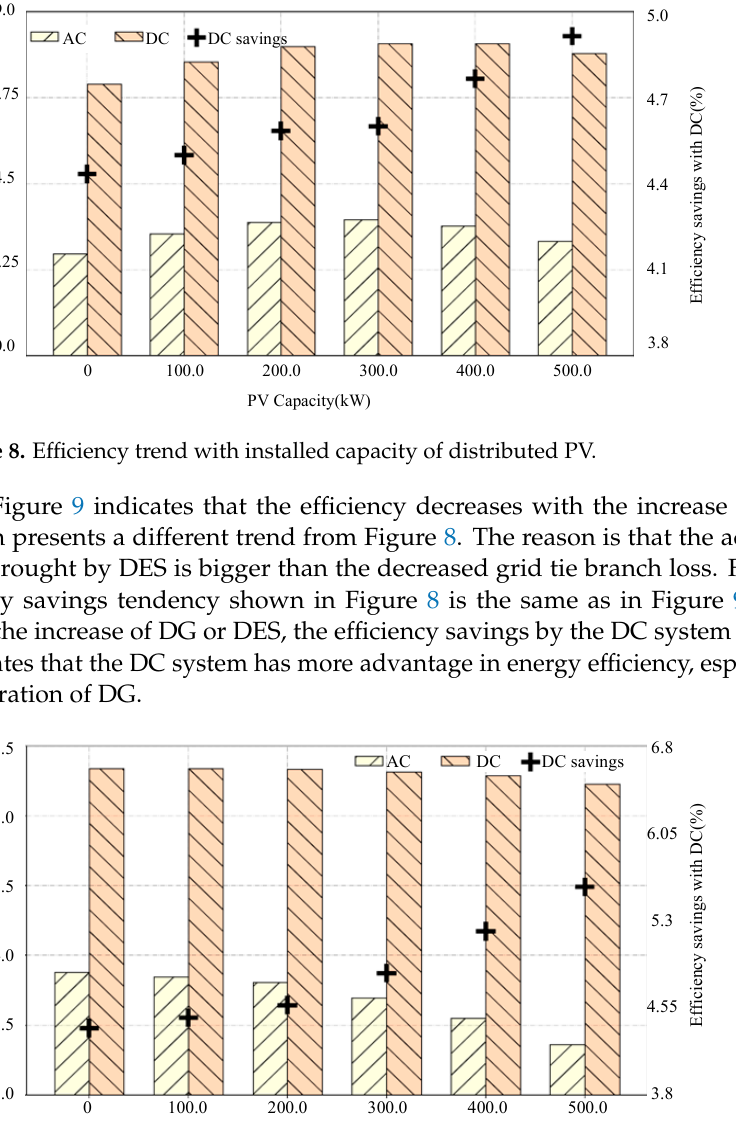
Figure 9. Efficiency trend with installed capacity of DES.